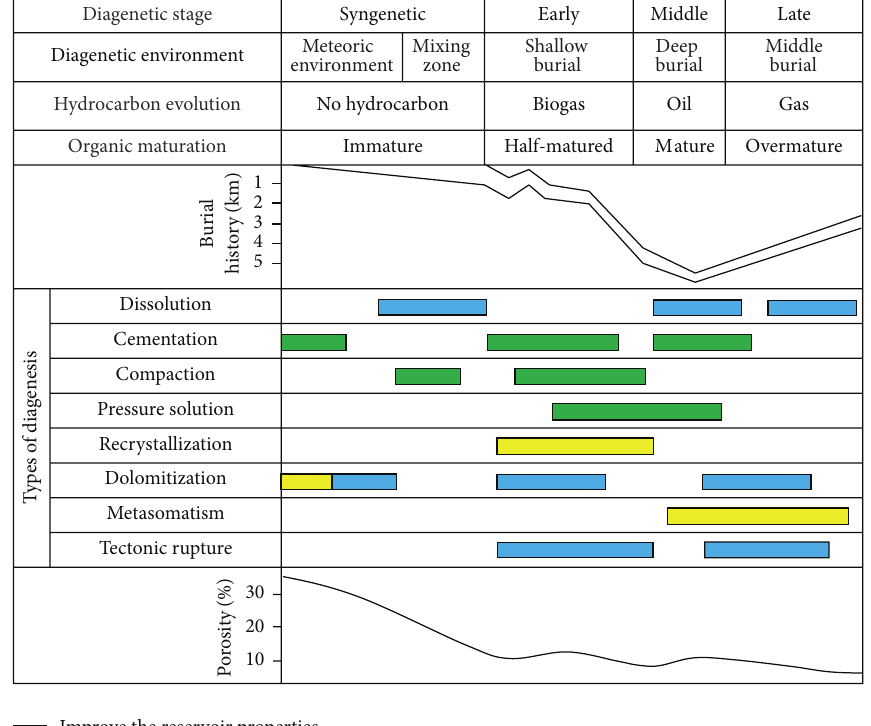
Figure 15: Characteristics of diagenetic